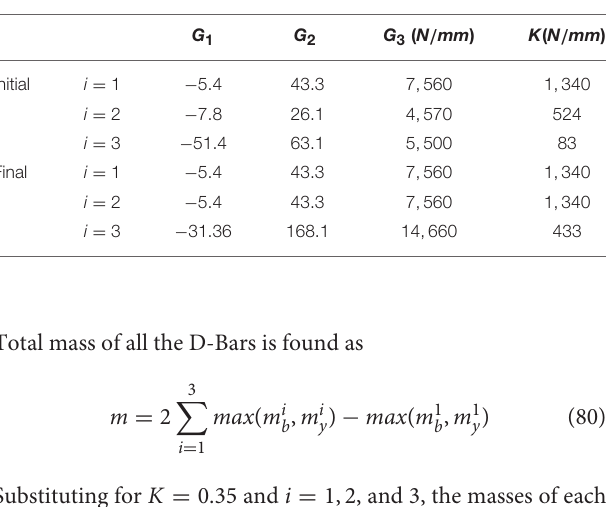
TABLE 4 | Values of the gains and stiffness of the D-Bars for initial and final